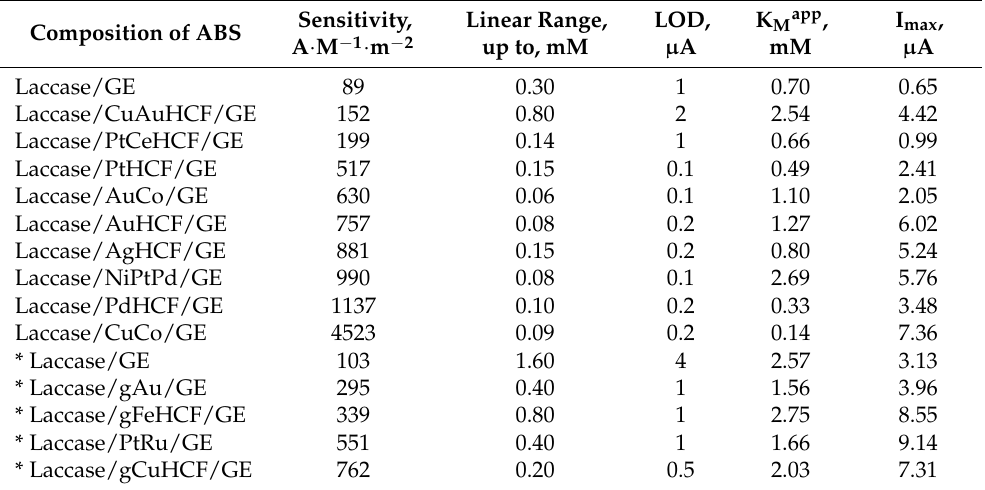
Table 1. The main operational parameters of the constructed ABSs for catechol analysis. Composition of ABS